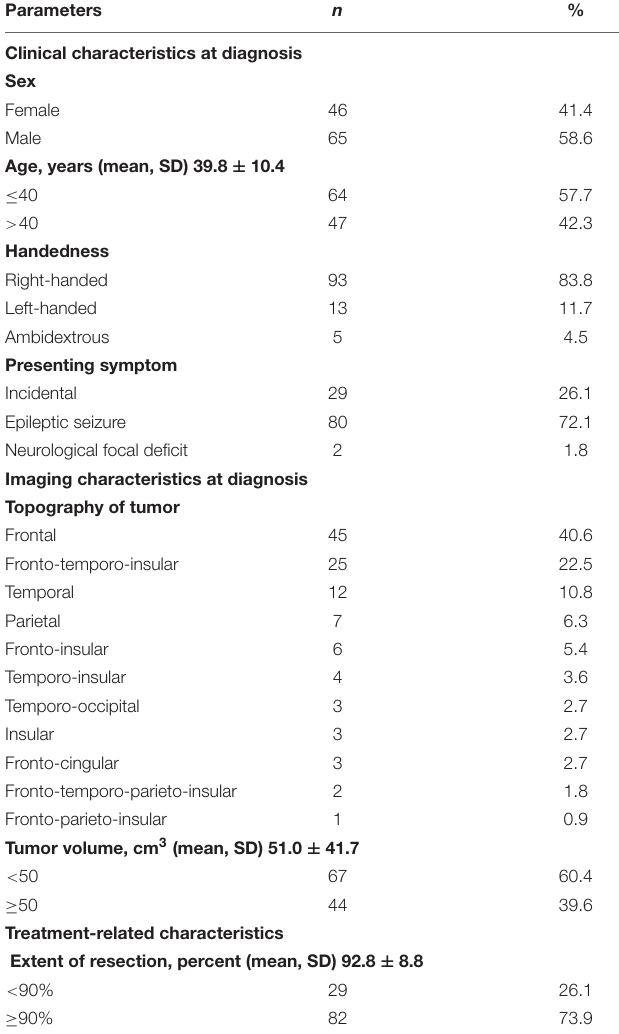
TABLE 1 | Main characteristics of the study